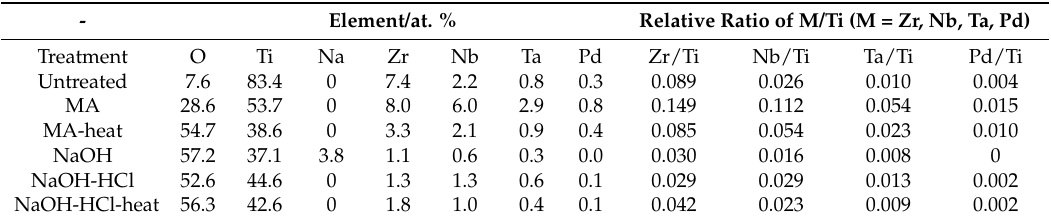
Table 2. Results of energy dispersive X-ray spectrometry (EDX) analysis on the surfaces of Ti–15Mo–5Zr–3Al alloy untreated and subjected to acid and heat treatments with or without NaOH treatment. - Element/at. % Relative Ratio of M/Ti (M = Mo, Zr, Al) Treatment Untreated MA-heat NaOH NaOH-HCl NaOH-HCl-heat Table 3. Results of EDX analysis on the surfaces of Ti–15Zr–4Nb–4Ta alloy untreated and subjected to acid and heat treatments with or without NaOH treatment. - Element/at. % Relative Ratio of M/Ti (M = Zr, Nb, Ta, Pd)